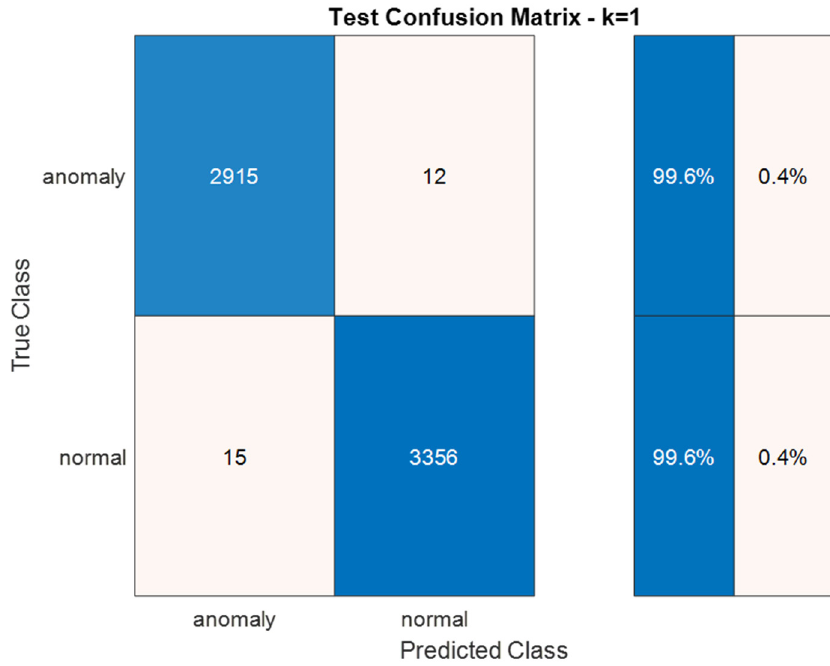
Figure 8. Best confusion matrix obtained on test set with K-NN classifier.